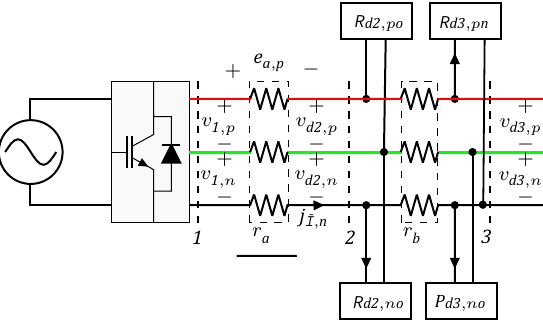
Figure 1. Schematic representation of a bipolar DC